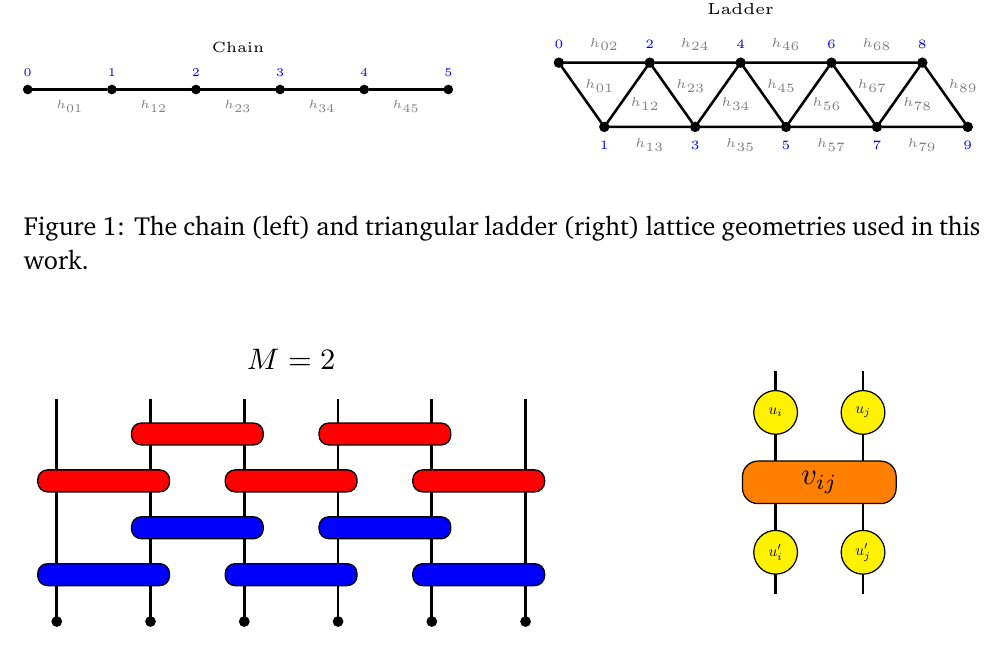
Figure 2: Left: A brickwall circuit with depth M = 2 for six qubits, with each color representing a M = 1 layer. Circles represent the initial state of the qubits and boxes indicate a two qubit unitary gate applied to a pair of neighboring qubits. Right: Parametrization of a two qubit unitary as a product of four single qubit gates and one two qubit